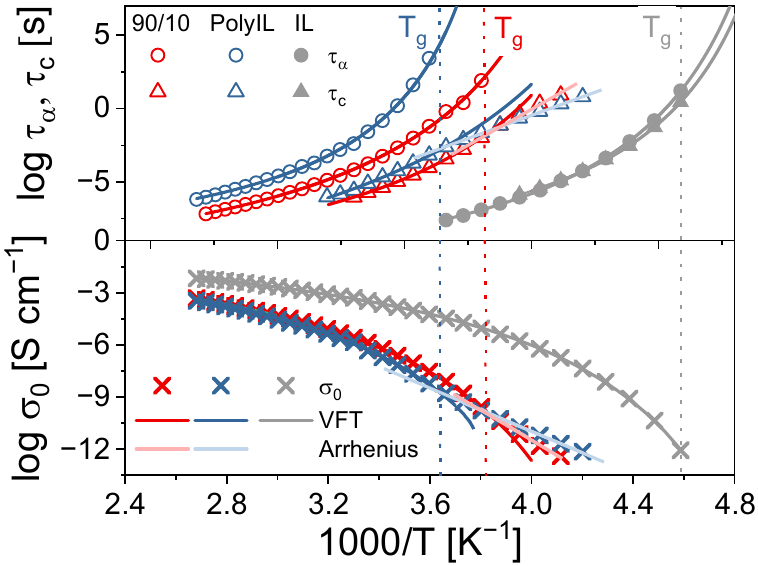
Figure 4. Temperature dependence of the segmental relaxation ( τ α ) , the relaxation of charge transport ( τ c ) , and the ionic conductivity ( σ ) of the IL, polyIL, and 90 wt% polyIL. Solid dark lines represent a VFT fit, whereas solid light lines describe an Arrhenius fit to the data. The dotted lines represent the respective T g